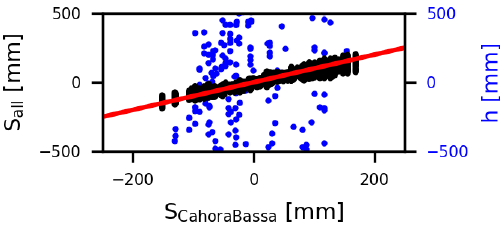
Figure 13. Temporal correlation of the GRACE observations for the cell in which the virtual station for Cahora Bassa is located (hor- izontal axis) and for (a) all cells within an area surrounding the virtual station with a radius of 3 ◦ (GRACE area of influence, ver- tical axis, black) and (b) the altimetry observation at Cahora Bassa (vertical axis, blue). The 1 : 1 line is visualized in red. The rela- tively strong temporal correlation between the GRACE cells could be a result of the strong seasonality in this